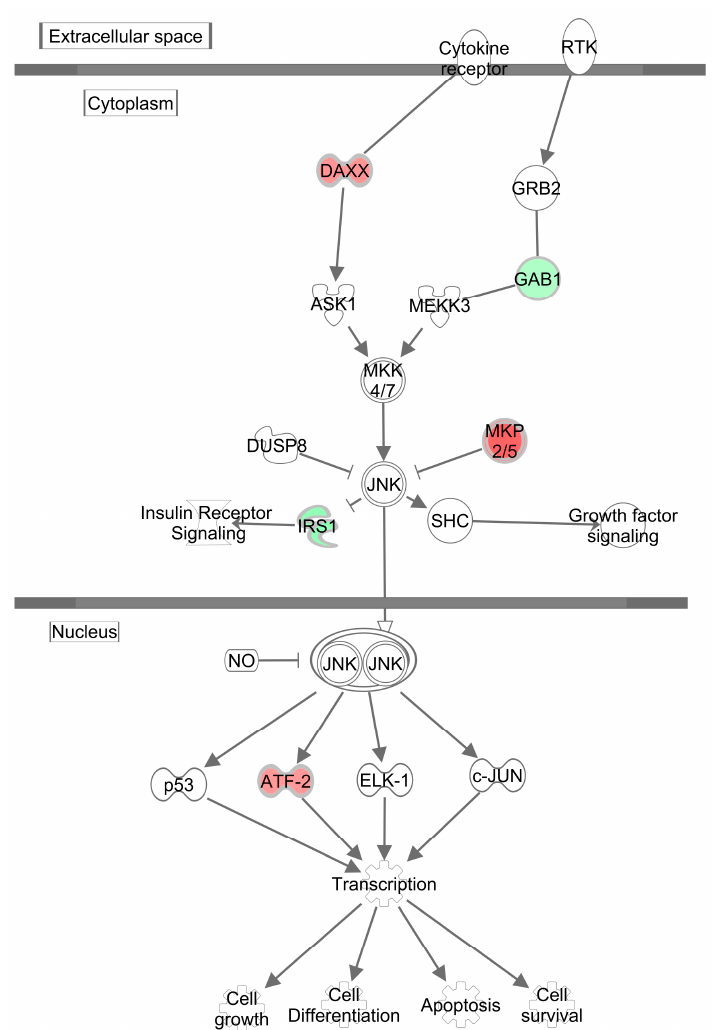
Figure 5. Simplified scheme of Sapk/Jnk signaling pathway showing significant enrichment (Benjamini–Hochberg corrected p = 1.11E-03) by transcripts differentially expressed in in white adipose tissue of MG (methylglyoxal)-treated HHTg (hereditary hypetriglyceridaemic) male rats compared to controls. The effect of MG on expression is shown in shades of green (downregulation) or red (upregulation). Created with Path Designer module, Ingenuity Pathways Analysis.